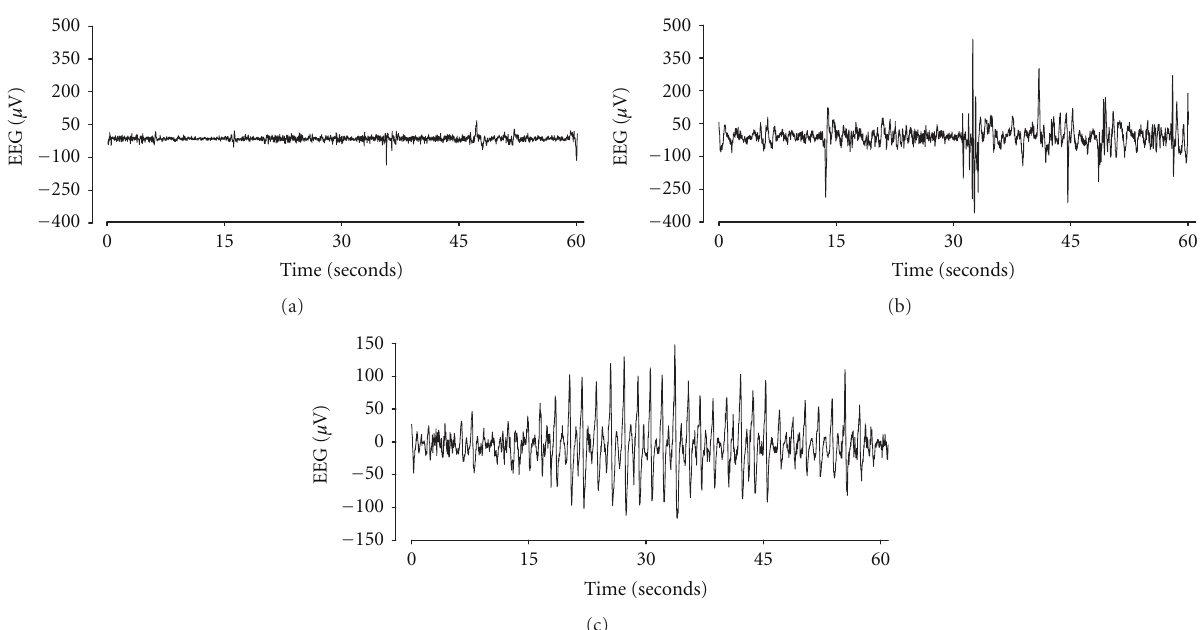
Figure 3: Example of sleep state architecture in a 0.7 gestation preterm fetal lamb before exposure to maternal dexamethasone (panel (a)) and after dexamethasone (panel (b)). The normal sleep patterns of fetal sheep at this age is composed of mixed EEG amplitudes and frequencies, with mean amplitude typically around 60–70 µ V. Transient waveforms (fast, sharp, and slow waves between 70–400 ms) are seen as part of this normal EEG patterns and their amplitude is typically between 70–150 µ V. After dexamethasone exposure, there is a significant change in sleep architecture characterised by a significant increase in EEG amplitude (with background amplitudes increased to above 100 µ V and spikes ranging between 200–600 µ V), and a general reduction in high-frequency activity. Seizures and seizure-like activity is also observed and an example of this is shown in panel (c). While many of these seizures were high amplitude, it is notable that many were relatively low amplitude. All figures are raw data from one